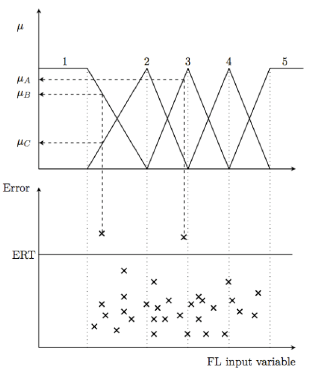
Fig. 15. FL sets and rules determination by the